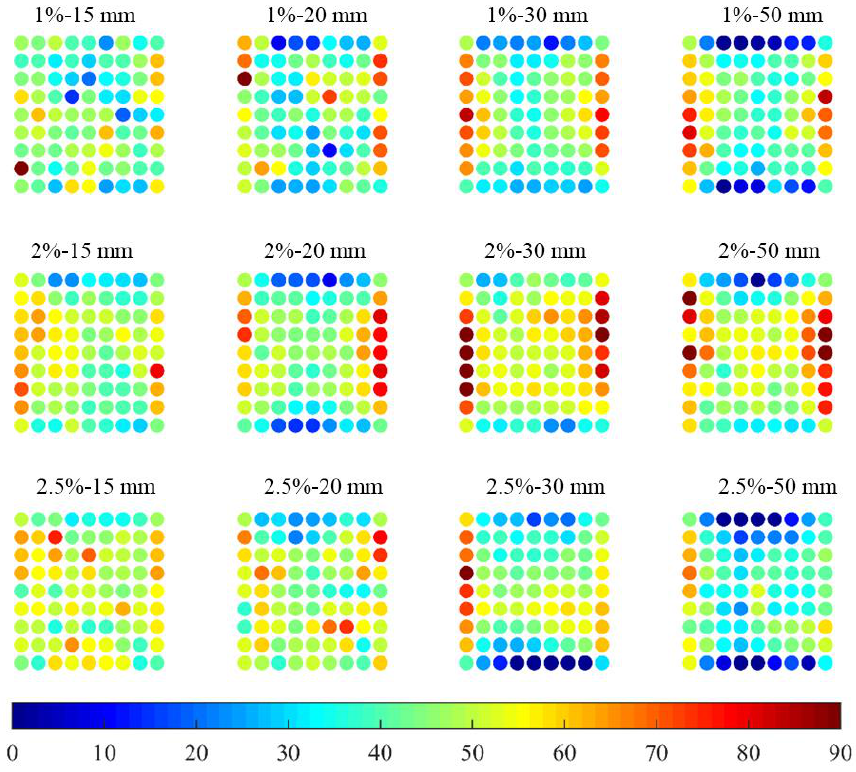
Figure 11. Fibre orientation angle distribution of all plates.